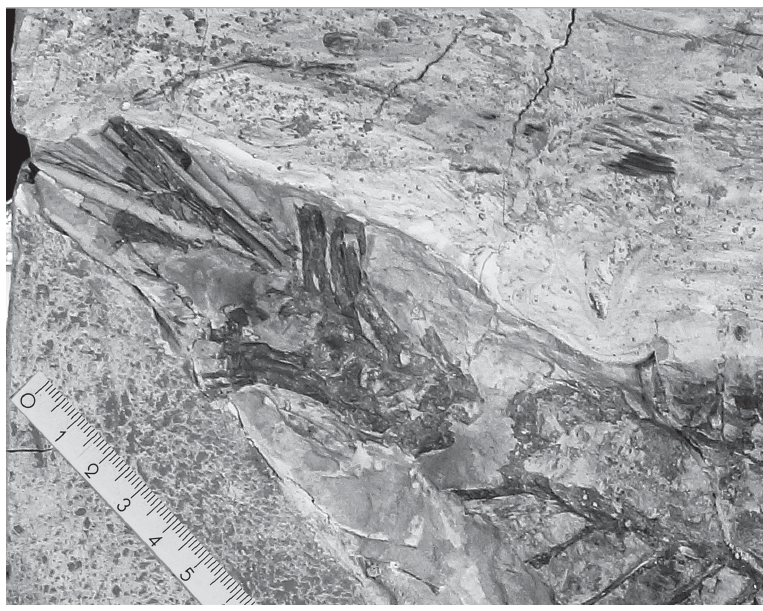
Fig. 21. Sigmapycnodus giganteus gen. et sp. nov., holotype, tail region (CLC